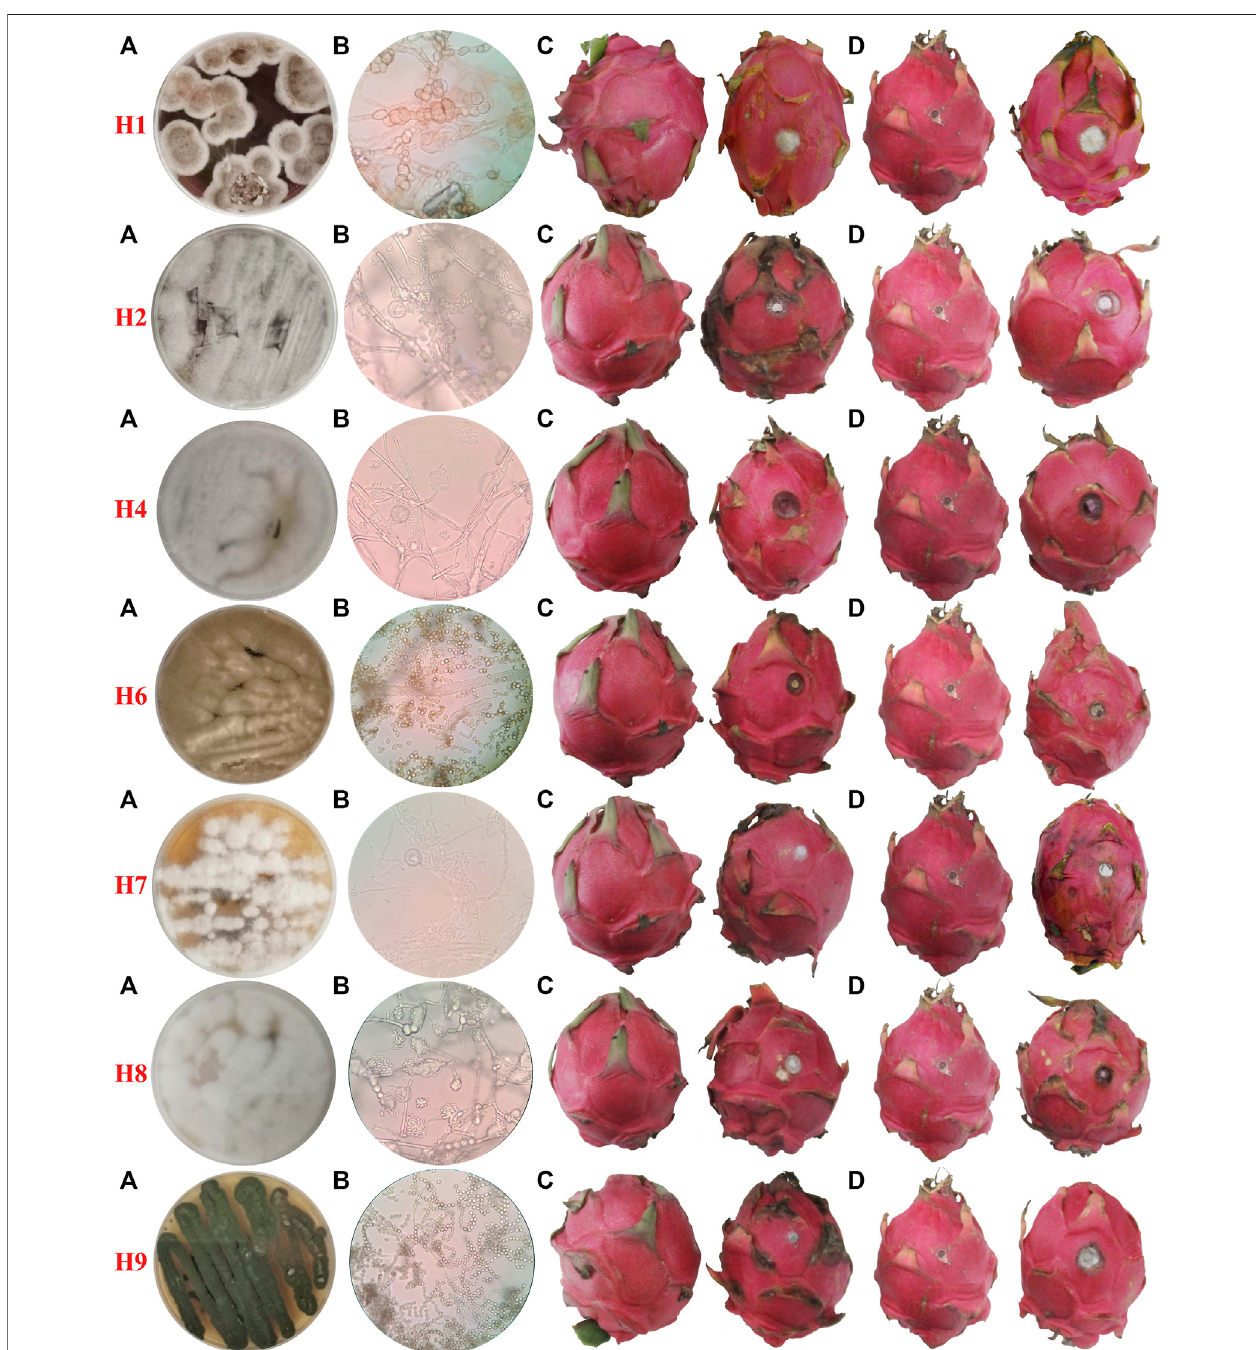
FIGURE 1 | Morphological characteristics of pathogens and pathogenicity con fi rmation. (A) Colony morphology on the PDA plate. (B) Microscopic image of conidia taken with ×400 magni fi cation, (C) non-injury inoculation, and (D) injury inoculation; fruits on the right were inoculated with mycelia “ cakes, ” and the ones on the left are blank